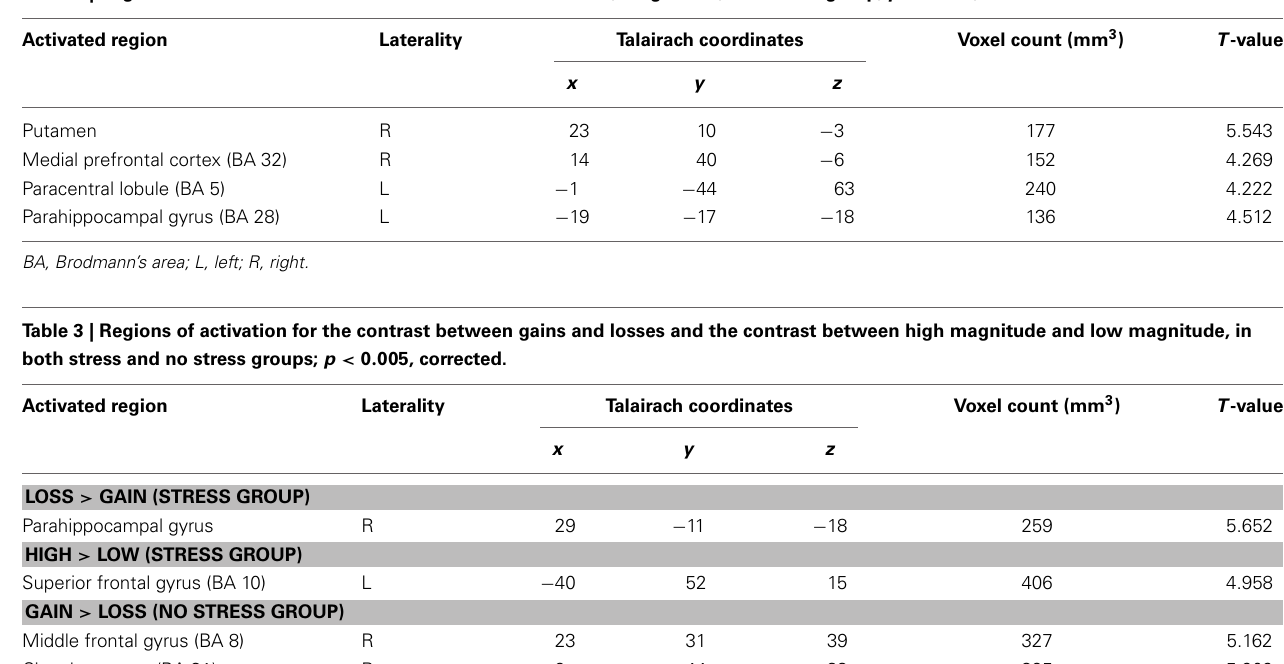
Table 2 | Regions of activation in an interaction contrast of valence, magnitude, and stress group; p < 0 . 005, corrected.